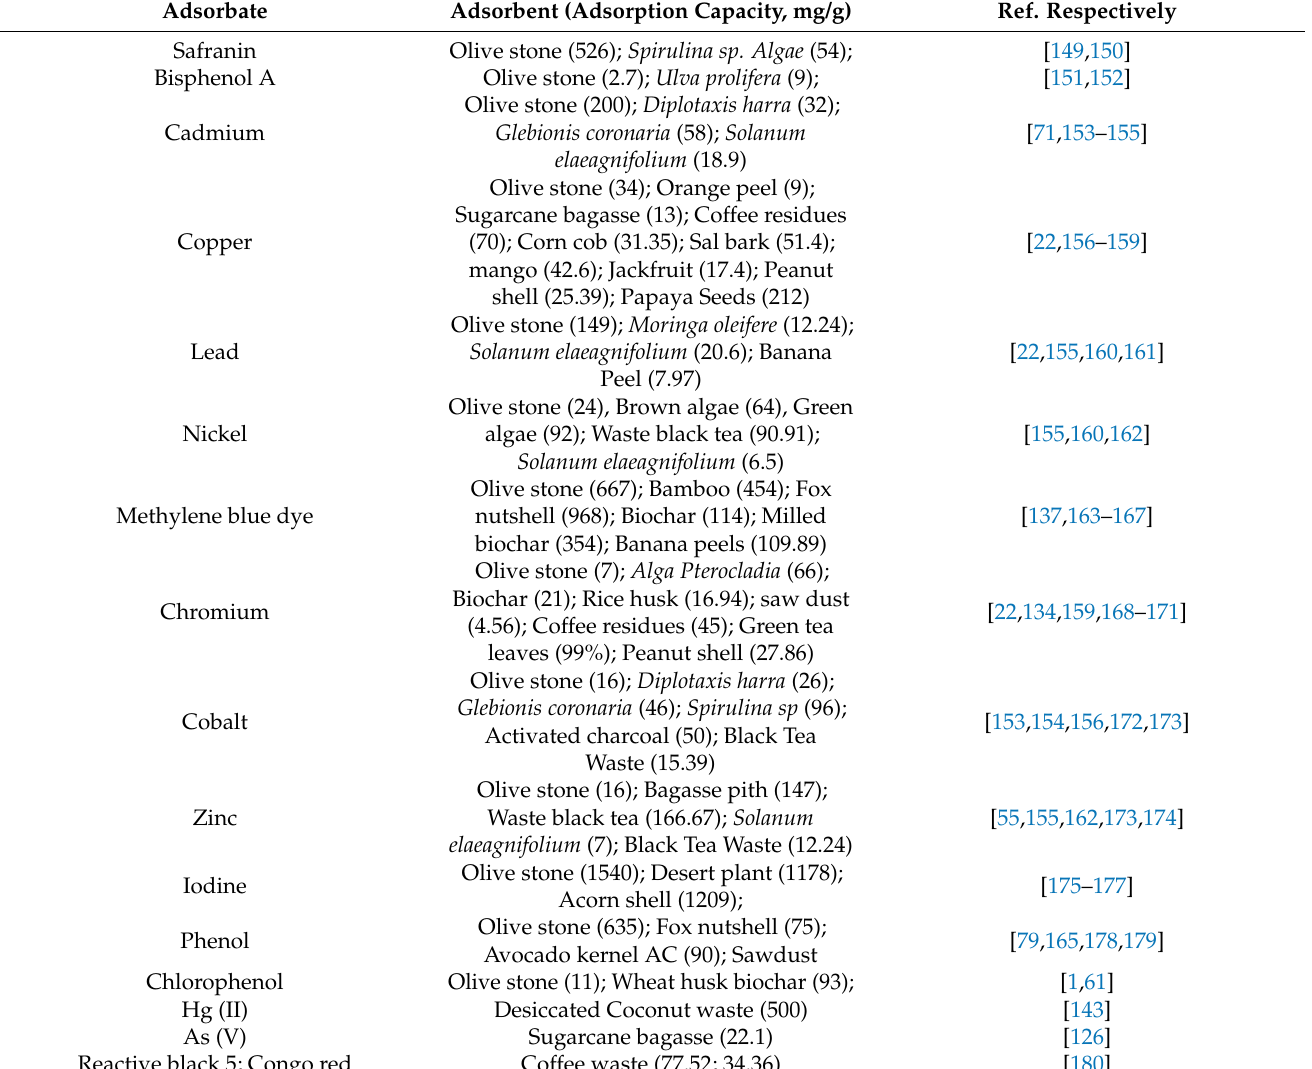
Table 1. Highlight of sorption capacity of some